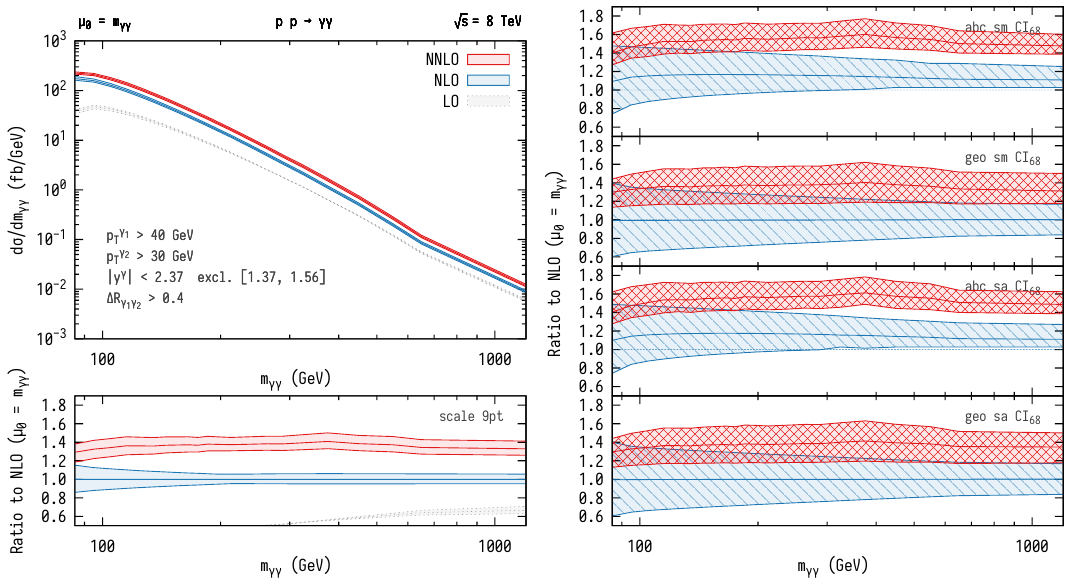
Figure 19 . Di-photon production up to NNLO with µ 0 = m γγ as the central scale choice. Left: absolute dσ/dm distributions and 9-point scale variation envelopes normalised to the NLO predic- γγ tion at µ . Right: 68% CIs for the abc and geometric models using the scale-marginalisation (top) 0 and scale-averaging (bottom) prescriptions (also normalised to